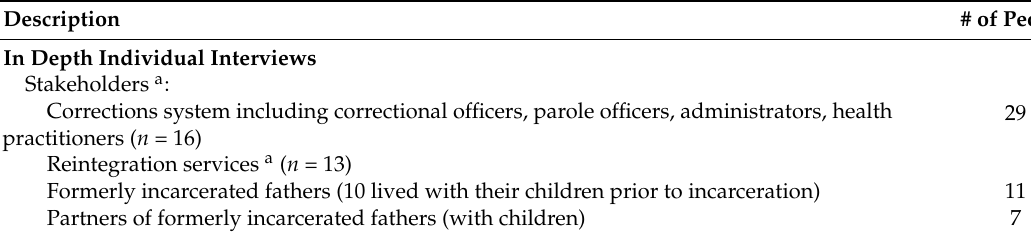
Table 1. Description of